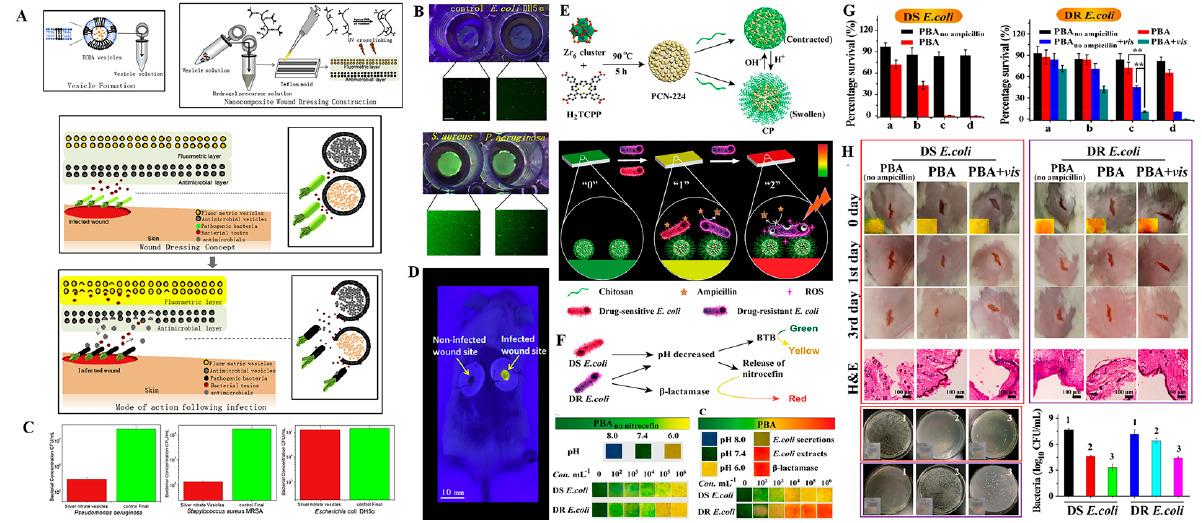
Figure 11. Nano-based intelligent wound dressings for the all-in-one infection detection and